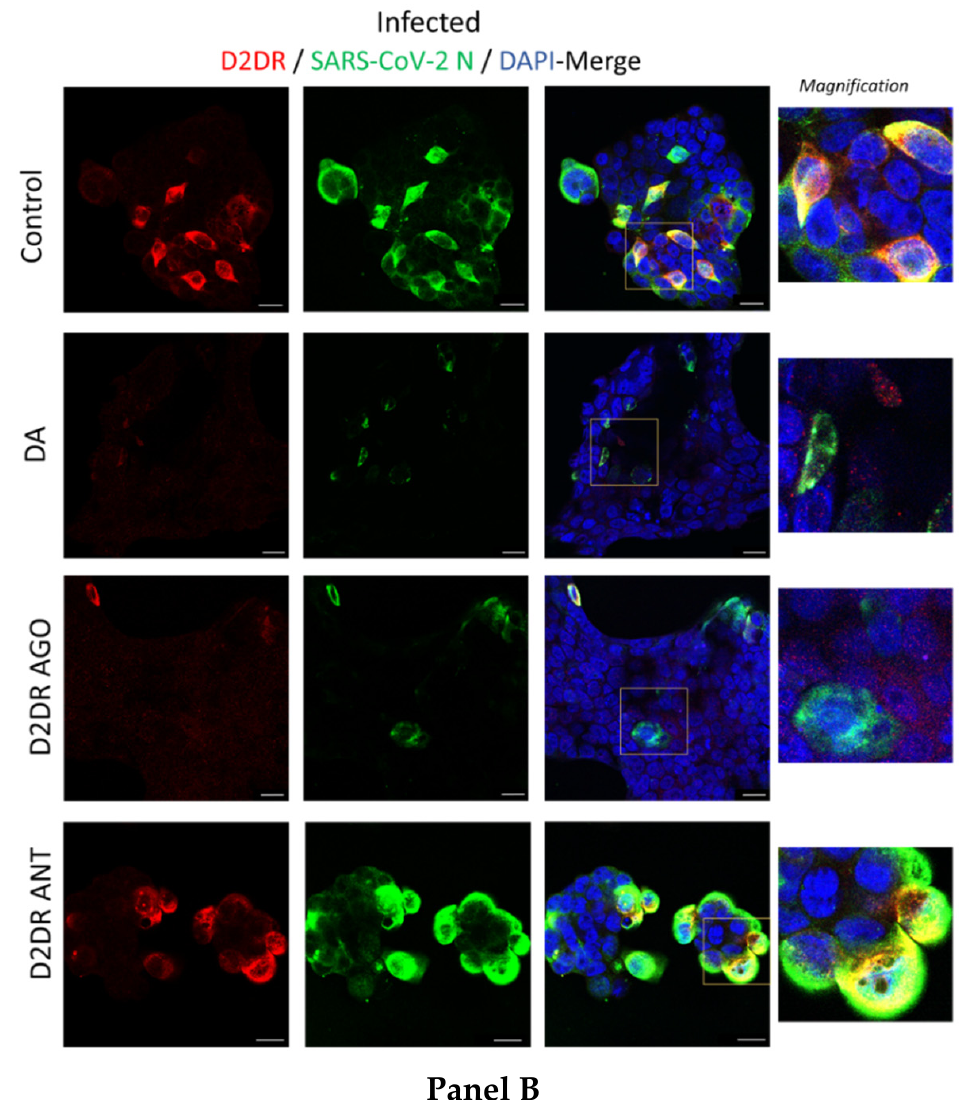
Figure 5. Representative images of combined immunofluorescence for D2DR and SARS-CoV-2 N protein. The anti-replicative effects of dopamine (DA, 50 µ M) and D2DR agonist quinpirole (10 µ M) at 48 h post-infection are associated with downregulation of D2DRs in either Uninfected (Mock, Panel A ) and SARS-CoV-2-Infected cells ( Panel B ). Compared with Uninfected Control cells ( Panel A , Control), SARS-CoV-2 produces a dramatic clustering of D2DRs both at the plasma membrane and adjacent intracellular compartments, where an impressive co-localization with the SARS-CoV-2-N protein occurs ( Panel B , Control). On the other hand, administration of DA, similar to the D2DR agonist, dramatically reduces D2DR staining leading to the formation of intracellular red puncta in both Uninfected (DA, and D2DR Ago, Panel A ), and SARS-CoV-2-Infected (DA, and D2DR Ago, Panel B ) cells. Such a scenario is not observed following D2DR antagonist administration in either Uninfected (Mock), or SARS-CoV-2-infected cells (D2DR Ant, Panel A and Panel B , respectively). In SARS-CoV-2 infected cells, the reduction in SARS-CoV-2-N protein staining that is produced by either DA or the D2DR agonist ( Panel B ) goes along with a dramatic reduction of D2DR immunostaining and a disruption of their co-localization. This is instead occluded by the administration of the D2DR antagonist, whereby the co-localization between D2DR and N-SARS-CoV-2 protein is magnified, as evident by the occurrence of both wide, overlapping areas and large intracellular puncta (D2DR Ant, Panel B ). Cells were incubated with primary antibodies (Mouse anti-D2DR B-10: sc-5303, 1:200,